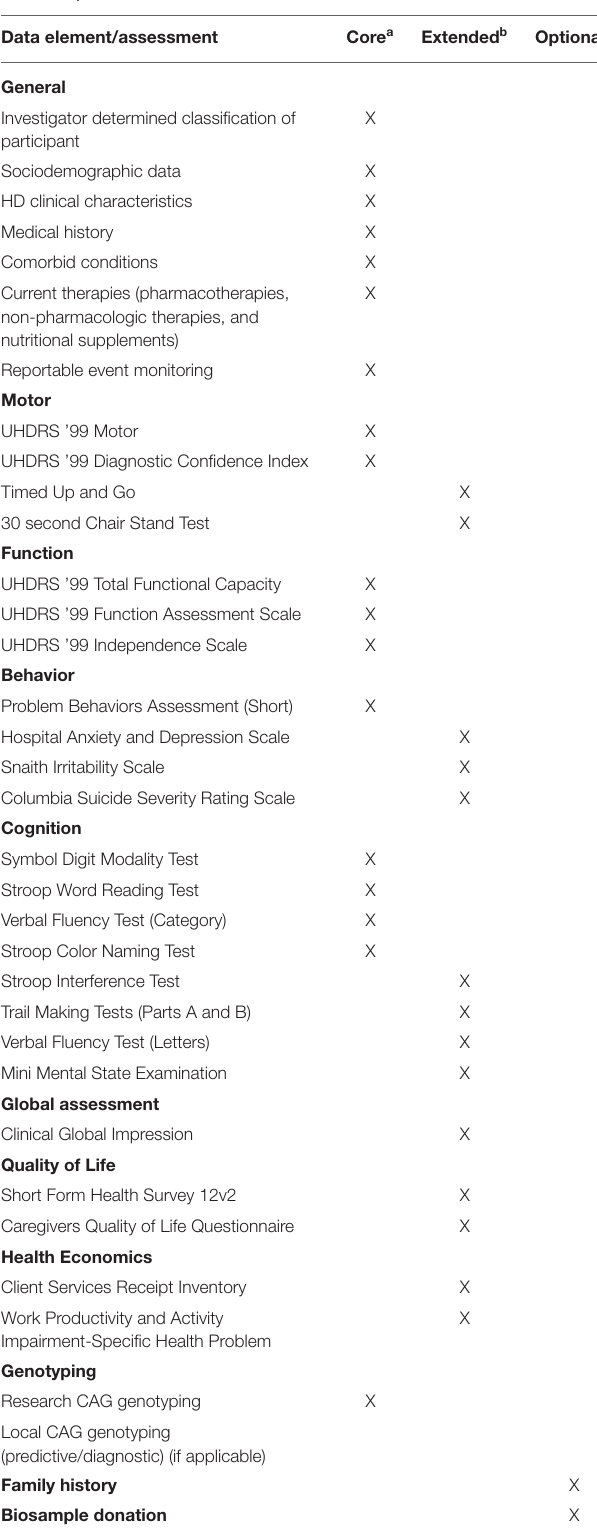
TABLE 2 | Enroll-HD data elements and assessments.